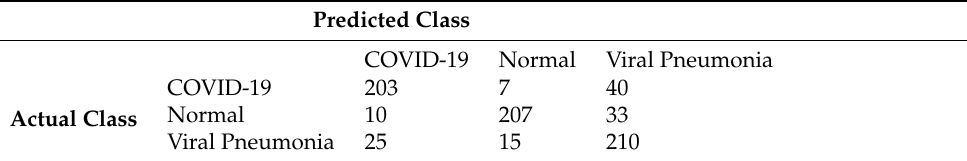
Table 9. Confusion matrix for three classes on the testing dataset for the best model.